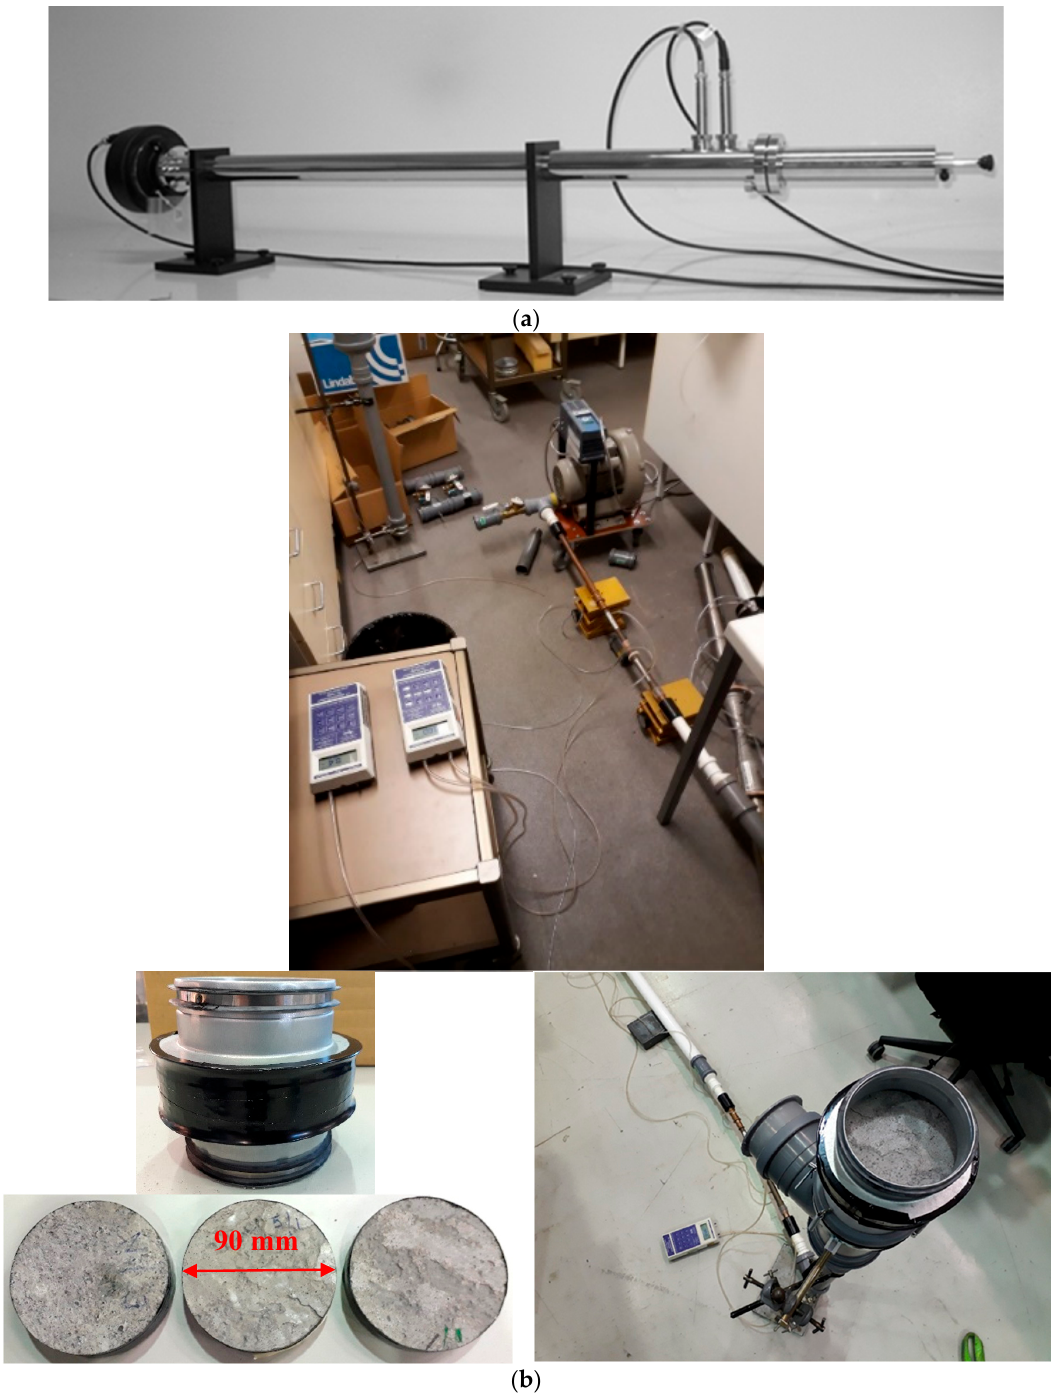
Figure 5. ( a ) Apparatus used to measure the acoustic indicators; ( b ) apparatus employed to measure airflow resistivity [25].